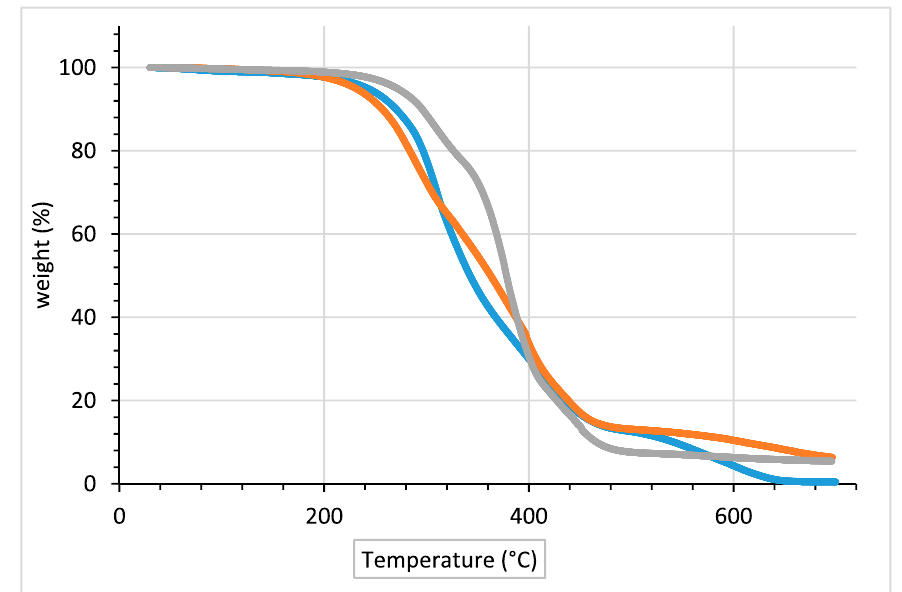
Figure 5. TGA curves for bio-PU made with bio-polyol 1 and 1 mol % (blue color), 2 mol % (red color) MoO 2 Cl 2 catalysts and literature procedure (grey color) [36].